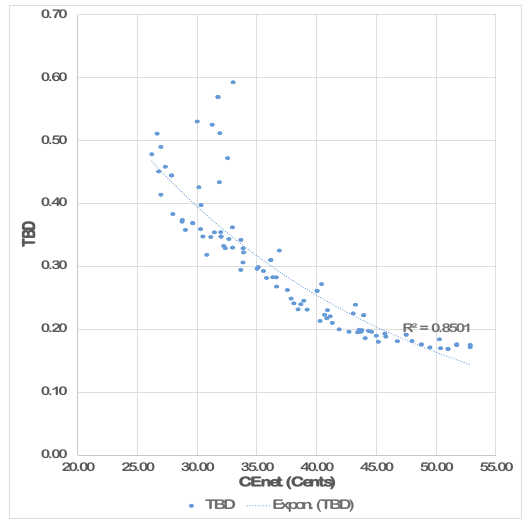
Figure 10. Relation between CEnet and TBD for a DRSREODLDG-based HEMS.